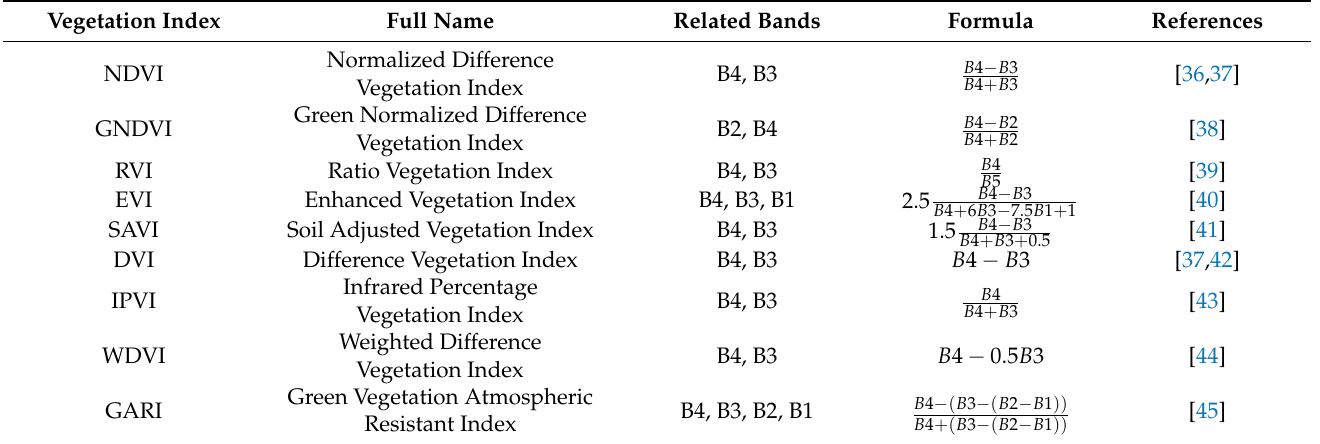
Table 5. Definitions, bands, and mathematical formulas for common vegetation indices of apple